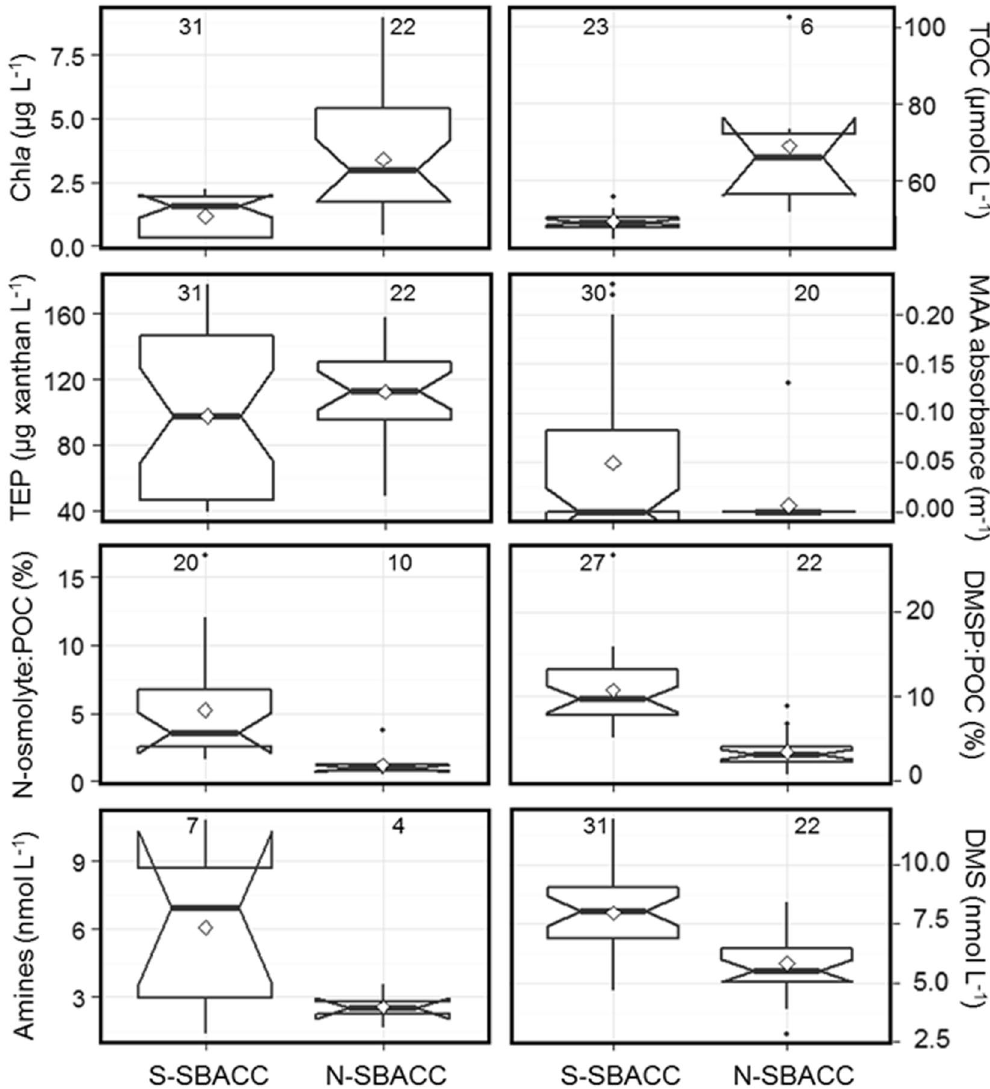
Figure 5. Seawater component occurrence south and north of the Southern Boundary of the Antarctic Circumpolar Current (S-SBACC and N-SBACC, respectively). The bold line at the centre is the median, the diamond is the mean, and the hinges represent the first and third quartiles. The lower end of the vertical bar is the minimum value, and the upper end is 1.5 times the inter-quartile range. The numbers inside each chart are the number of measurements. N-osmolytes (glycine betaine + choline) and DMSP are shown as their proportion to total particulate organic carbon. All median pairs are significantly different ( p < 0.05) except for transparent exopolymeric particles (TEP) and MAA absorbance. In the case of MAA, the mean is more meaningful than the median, because the many zeros in both populations drive the medians to zero; means are significantly